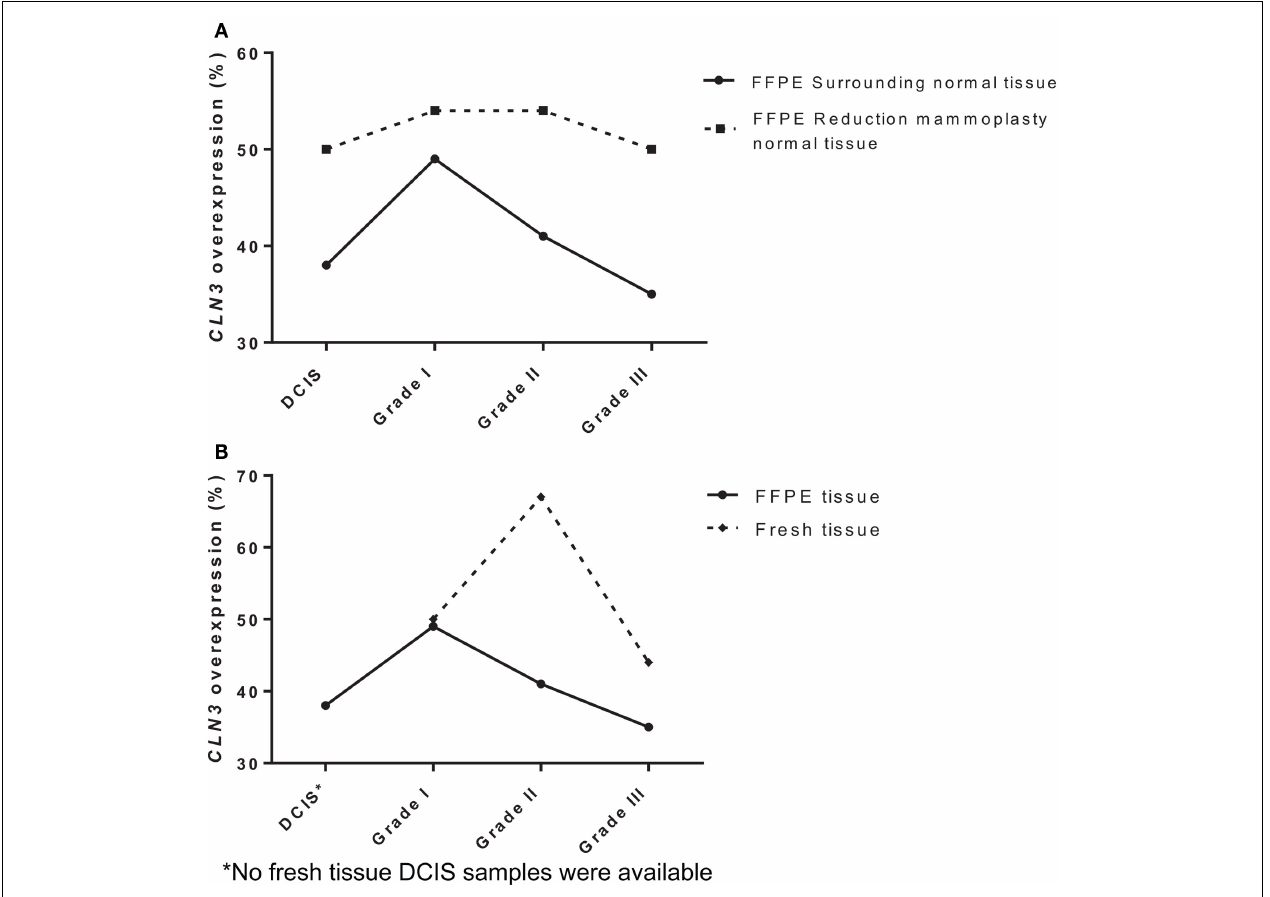
FIGURE 1 | Expression of CLN3 in breast adenocarcinoma samples (A) FFPE breast cancer tissue of different tumor grades (DCIS, IDC grades I, II, and III) were collected with surrounding normal tissue and normal tissue from reduction mammoplasties . Total RNA was extracted and quantitative real-time PCR experiments were performed using primers for the CLN3 gene. The RT-PCR was normalized using PGK1 RNA. The cut-off point for CLN3 overexpression was a 1.25-fold increase. (B) Fresh and FFPE breast tissue of different tumor grades (DCIS, IDC grades I, II, and III) were collected with surrounding normal tissue. Total RNA was extracted and quantitative real-time PCR experiments were performed using primers for the CLN3 gene. The RT-PCR was normalized using PGK1 RNA. The cut-off point for CLN3 overexpression was a 1.25-fold